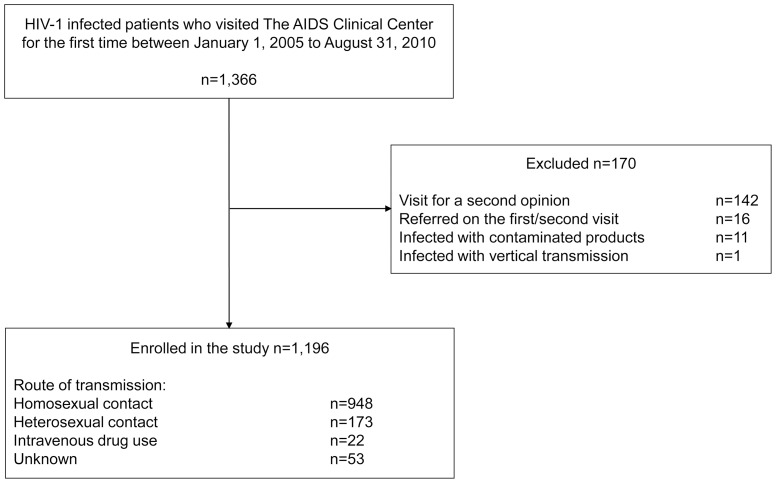
Patient enrollment.